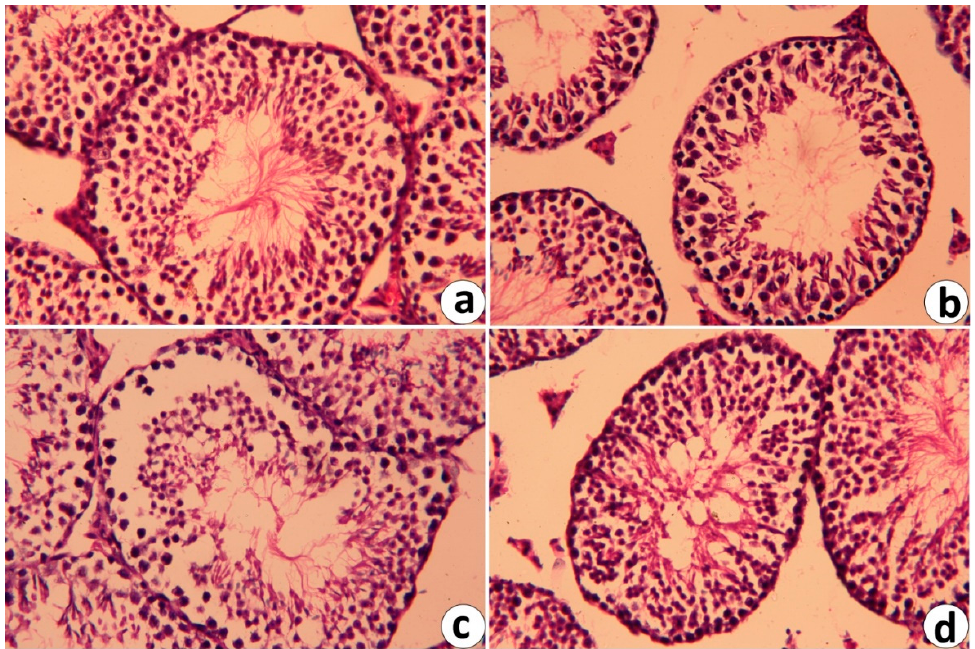
Figure 8. Photomicrographs of light microscope of testes of mice treated with RJ and CdCl 2 for 7 days. Cross sections of testes were stained with hematoxylin and eosin (400×). ( a , b ) testes from control and royal jelly (RJ) groups, respectively exhibiting typical features of seminiferous epithelium and Leydig cells (LC). ( c ) testes from the CdCl 2 -treated mice showing degenerative seminiferous tubules. ( d ) testis from the pretreated group with RJ against CdCl 2 showing an obvious preservation of spermatogenic epithelium in most seminiferous tubules.